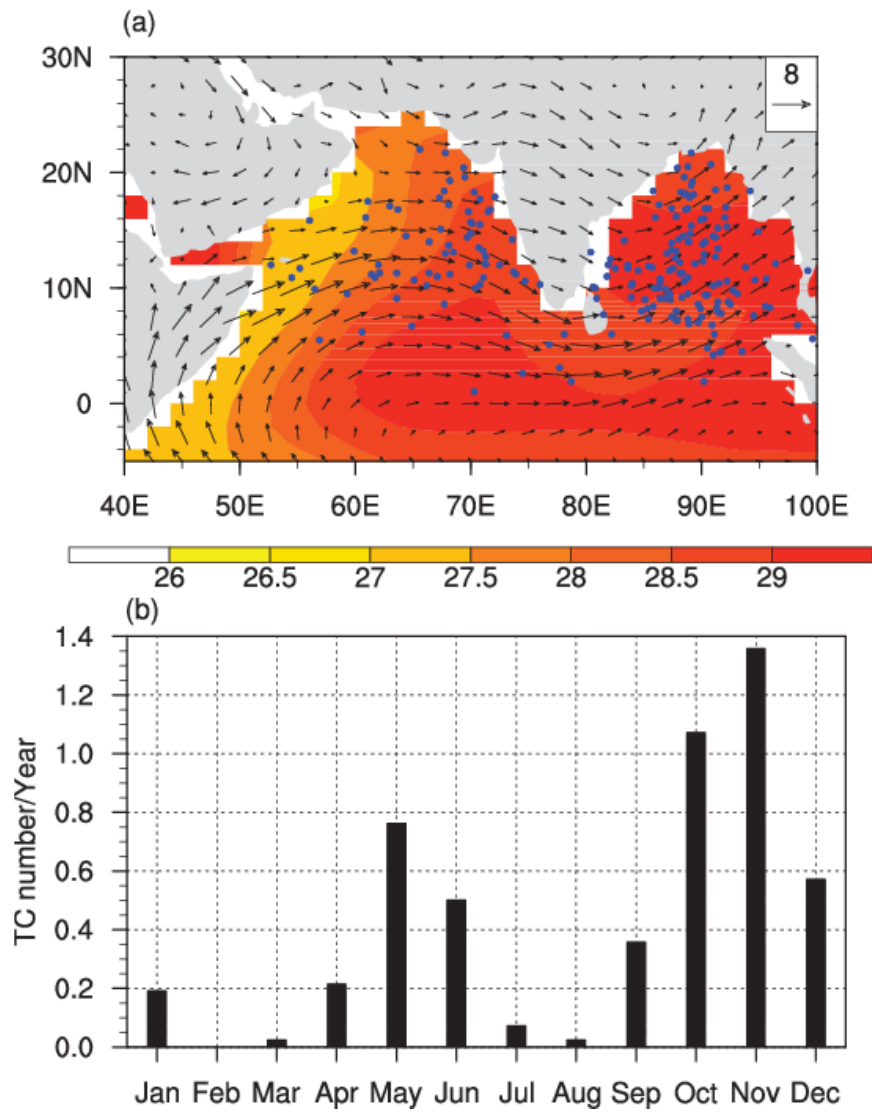
Figure 1. ( a ) The climatological mean SST (shaded, ° C) and lower-level winds (vector, m s − 1 ) during AMJJASOND for the period 1979–2020. The blue dots indicate the location of AMJJASOND TC formation. ( b ) The climatologically monthly mean variation of TC formation frequency over the NIO during the period 1979–2020.